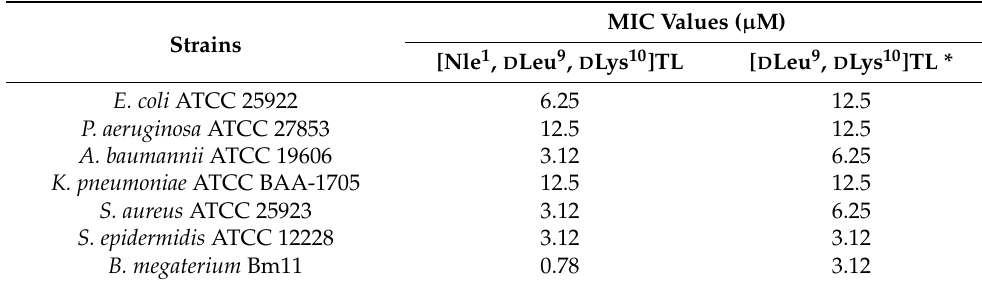
Table 2. MICs values of peptide [Nle 1 , D Leu 9 , D Lys 10 ]TL in comparison with [ D Leu 9 , D Lys 10 ]TL on selected Gram-positive and Gram-negative